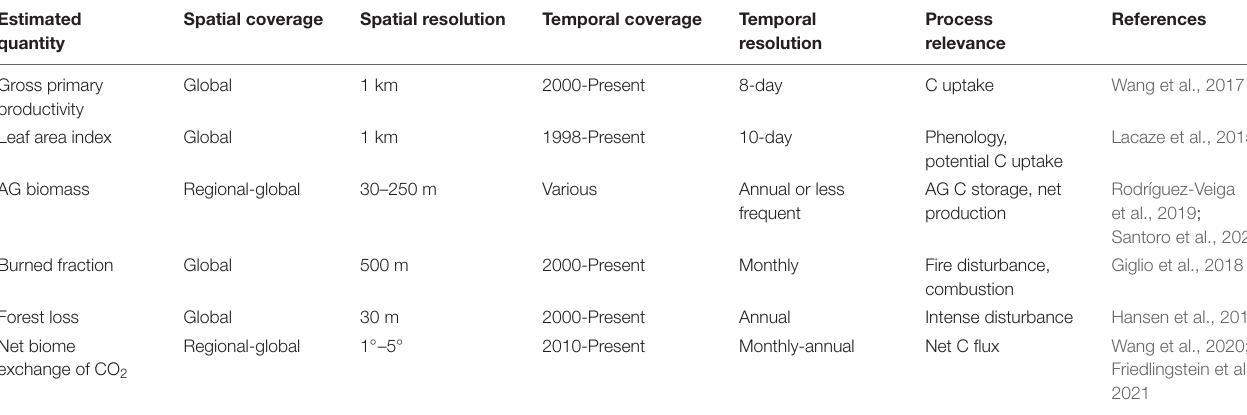
TABLE 1 | Examples of information available from earth observation. Estimated